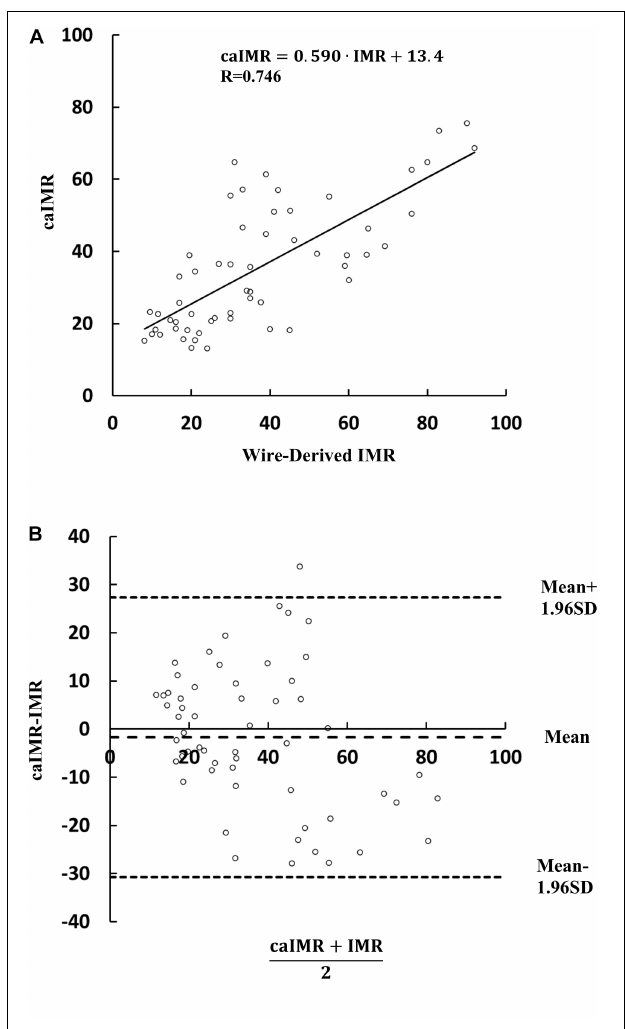
FIGURE 2 | Correlation and agreement between wire-derived IMR and caIMR. A A least-squares fit shows a relationship: caIMR = 0 . 590 · IMR + 13 . 4 (R = 0.746) (Vessel Number: n = 57) and (B) Bland-Altman plots for pairwise comparisons (mean difference: − 1.68; SD: 14.8; 95% limits of agreement − 30.7 to 27.4) (Vessel Number: n = 57). The student’s t -test shows p value of 0.654 (Vessel Number: n = 57).